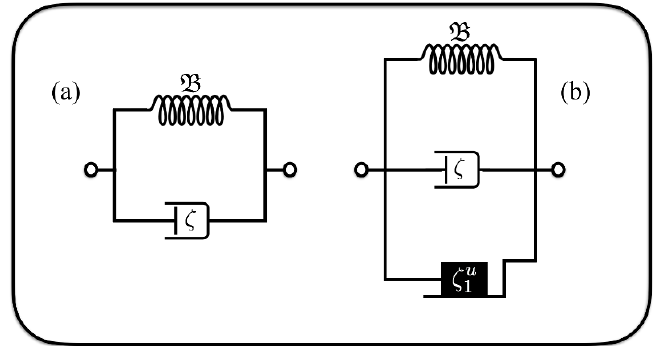
Figure 1 . Material diagrams for the bulk stresses sector of (a) Kelvin-Voigt model and (b) Bingham-Kelvin model. As all elements are connected in parallel (spring, dashpot and sliding frictional element) the total stress is given by the sum of each of the individual